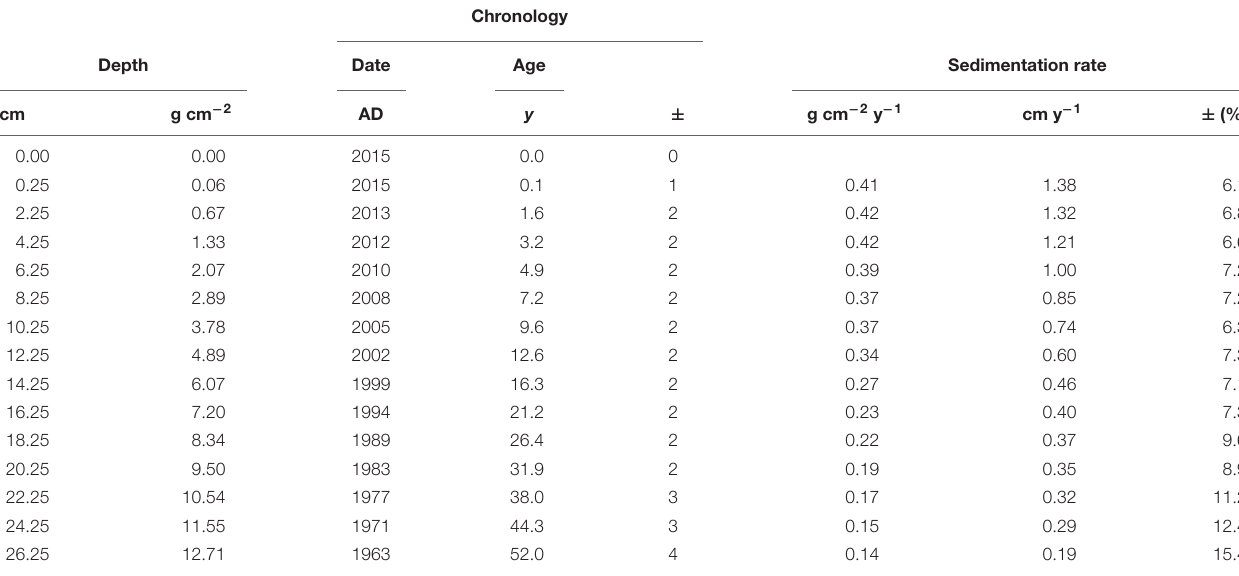
TABLE 2 | 210 Pb chronology of Sky Pond (SKP) corresponding to Figure 2